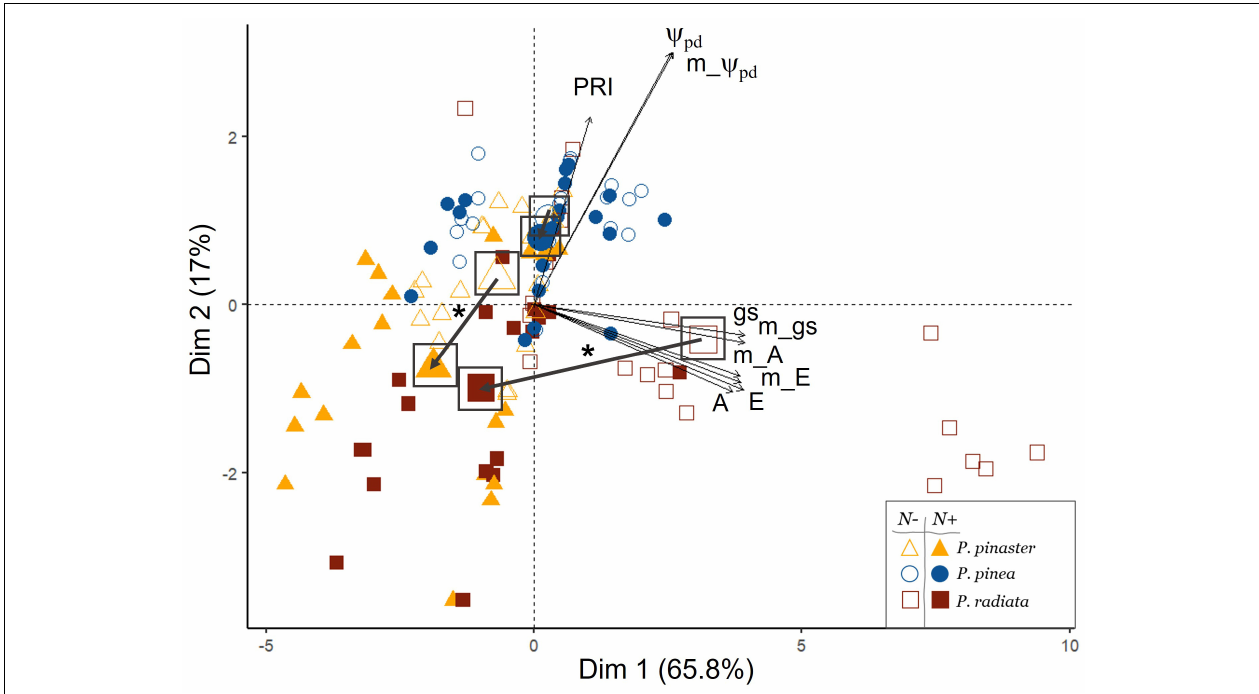
FIGURE 2 | Principal component analysis (PCA) of ecophysiological parameters of the three Pinus species, considering the Bursaphelenchus xylophilus inoculation treatment (N– non-inoculated/N+ inoculated). Mean values of each group (inoculation treatment by species) are represented by a bigger symbol and highlighted by a square; an arrow represents the bidimensional difference between mean values of each group and an asterisk (*) represents significant differences of PC1 and/or PC2 between groups. Physiological parameters abbreviations: PRI, photochemical reflectance index; (cid:57) pd , water potential predawn; gs, leaf conductance; E, transpiration; A, carbon assimilation; m, minimum.